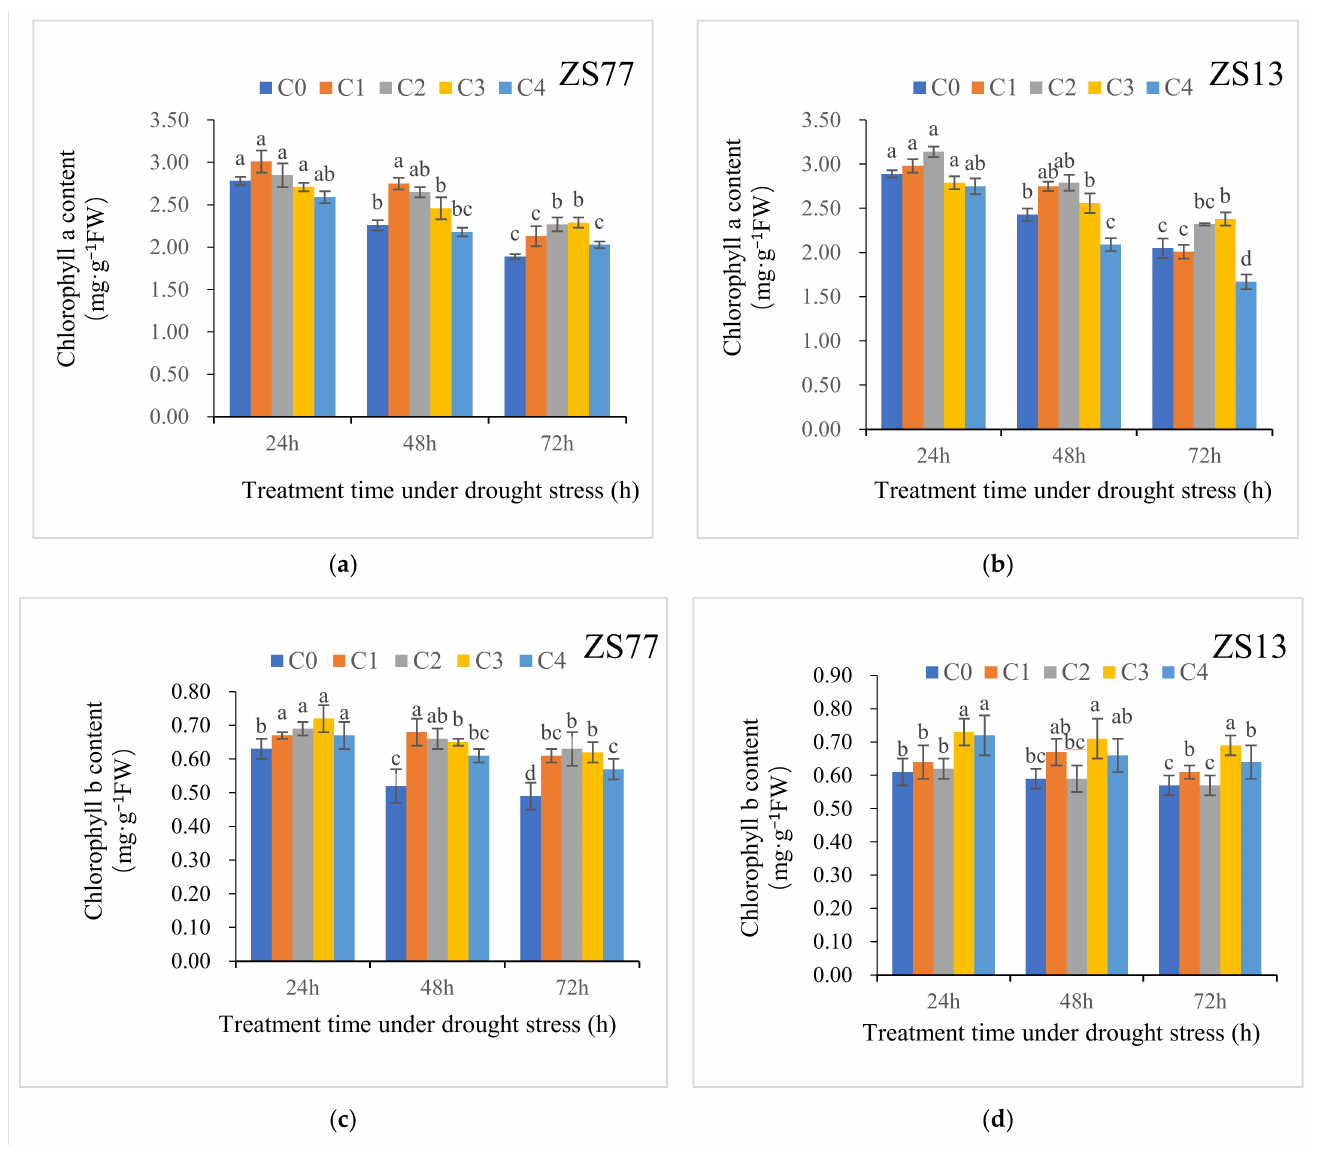
Figure 1. Effect of different concentrations of exogenous SA solution 0 (C0), 1.00 (C1), 2.00 (C2), 4.00 (C3), and 8.00 mg · L − 1 (C4) on chlorophyll a ( a , b ) and b ( c , d ) content in sweet potato leaves under drought stress. ZS77 and ZS 13 refer to sweet potato varieties Zheshu 77 and Zheshu 13 respectively, the same as in following figures Bars with different letters indicate significant differences ( p < 0.05). Table 2. Effects of drought stress on photosynthetic characteristics of sweet potato